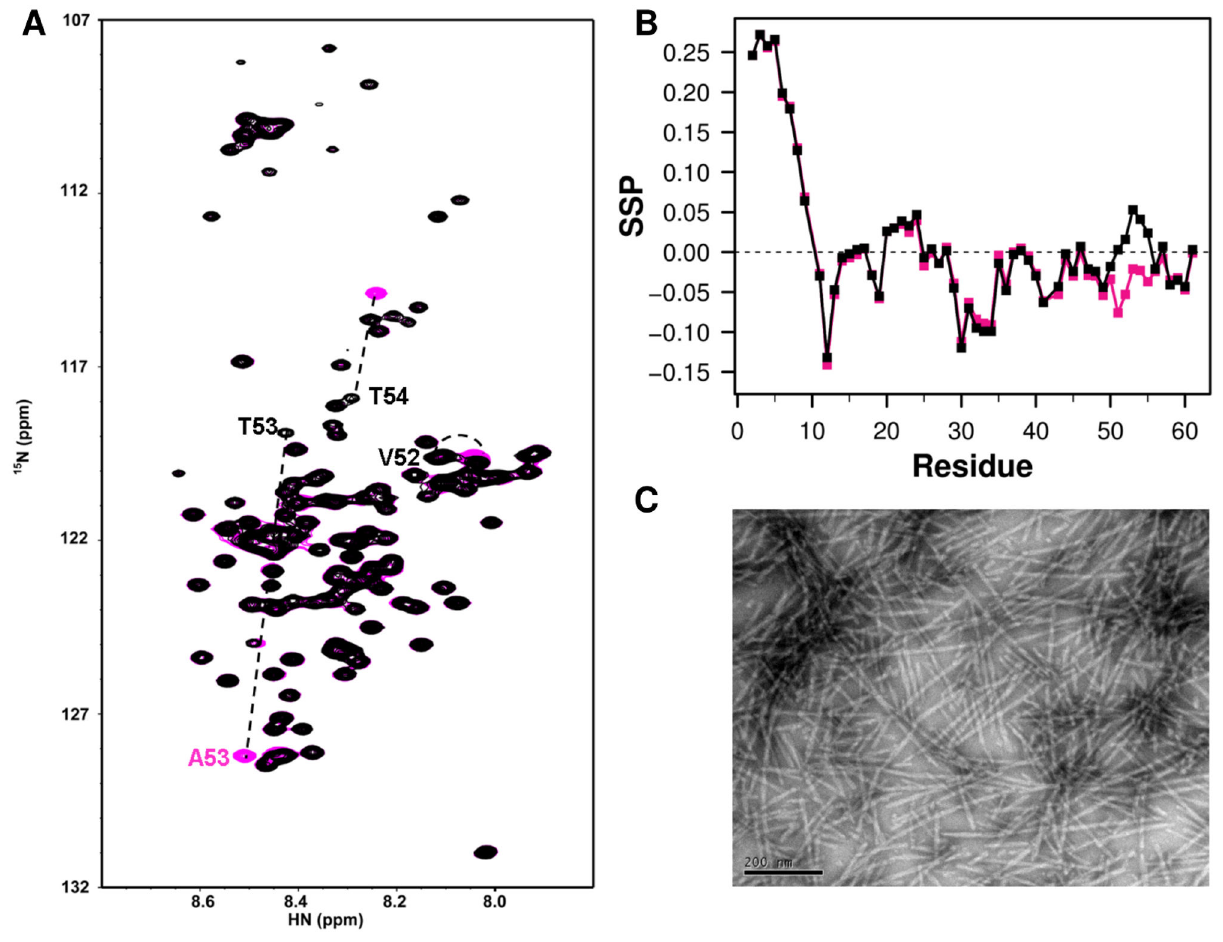
Figure 2. NMR and fibril morphology comparison of Ac-WT and Ac-A53T. A. Overlay of 15 N- 1 H HSQC of Ac-A53T (black) and Ac-WT(magenta) at 15 °C in PBS buffer at pH 7.4. B. SSP analysis of Ac-WT (magenta) and Ac-A53T (black) plotted for the N- terminal region. The overlay of the rest of the proteins can be seen in Figure S2. C. Negatively stained electron micrographs of the end products of fibril formation of Ac-A53T fibril. The scale bar is 200 nm. doi: